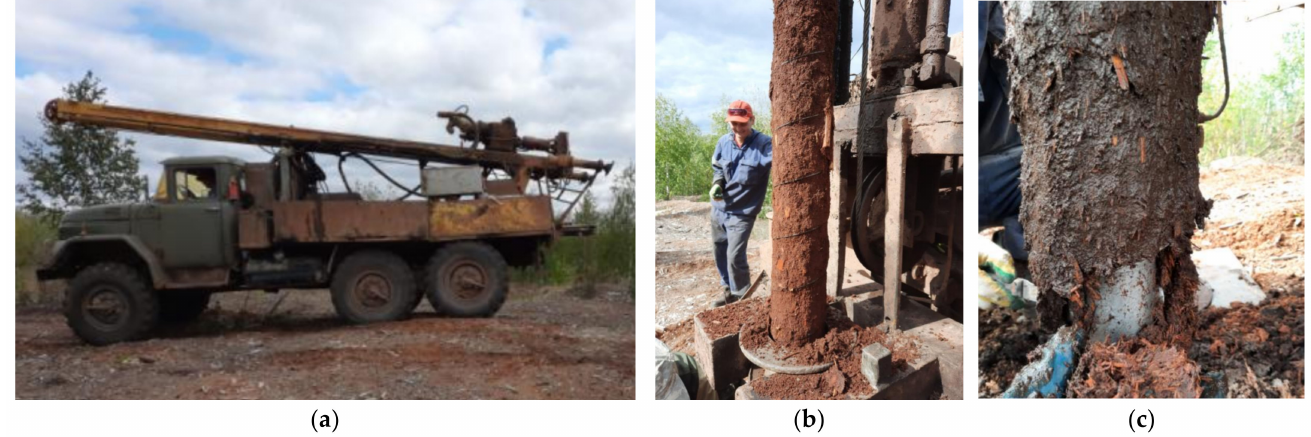
Figure 2. Sampling process: ( a ) URB-2A drilling rig; ( b ) general view of the drilled core; ( c ) BWW condition and